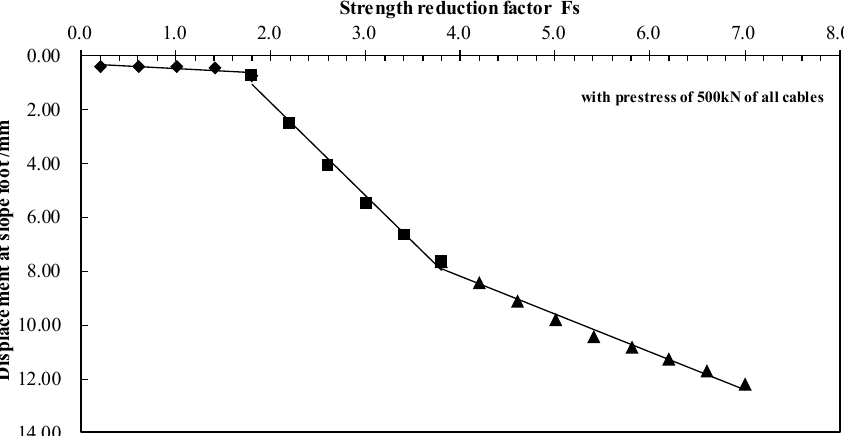
Figure 4. The relationship between the displacement of slope foot strengthened by prestressed anchor cables and the strength reduction factor (obtained by the inflection point method).